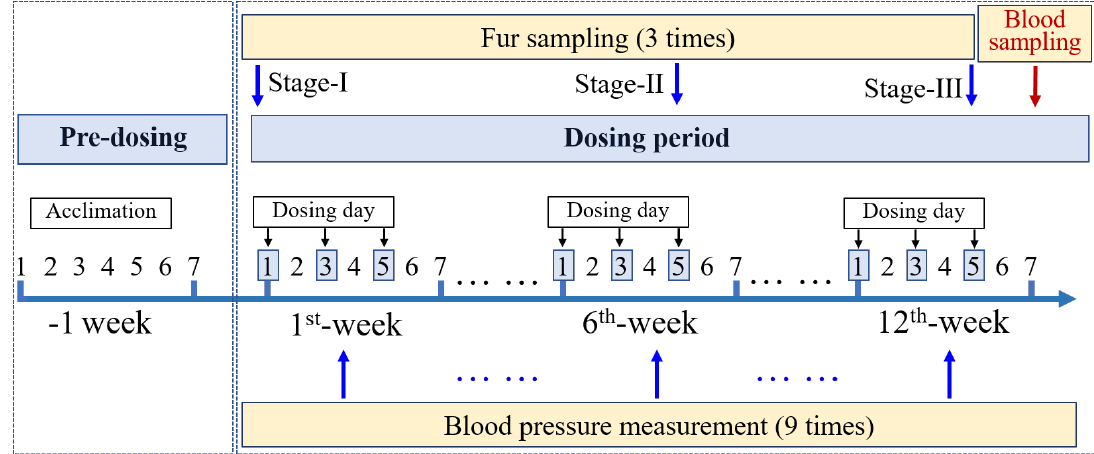
Figure 1. A schematic of the study design of the animal experiment.